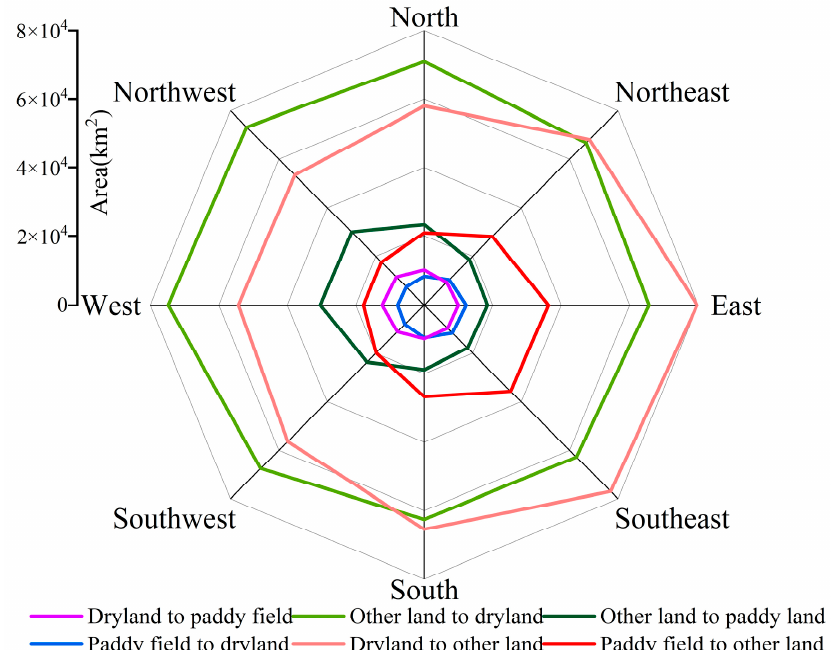
Figure 8. Land conversion between paddy field, dryland, and other land at different slope aspects from 1990 to 2020.